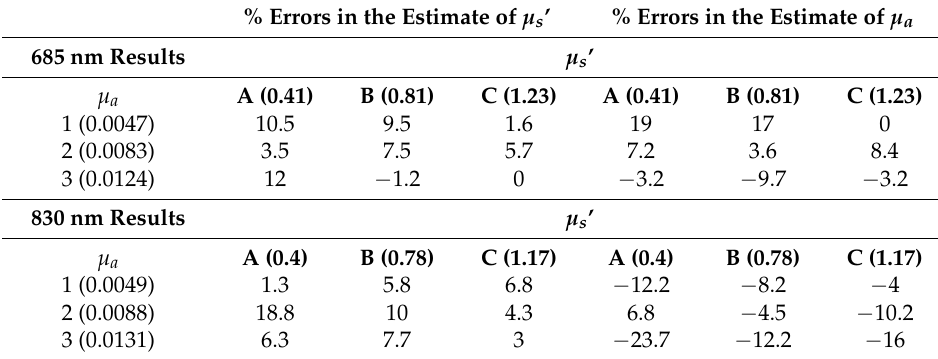
Table 2. Relative errors in the accuracy assessment of the retrieved µ s ’ and µ a versus the actual µ s ’ and µ a for nine phantoms at two different wavelengths. % Errors in the Estimate of µ s ’ % Errors in the Estimate of µ a 685 nm